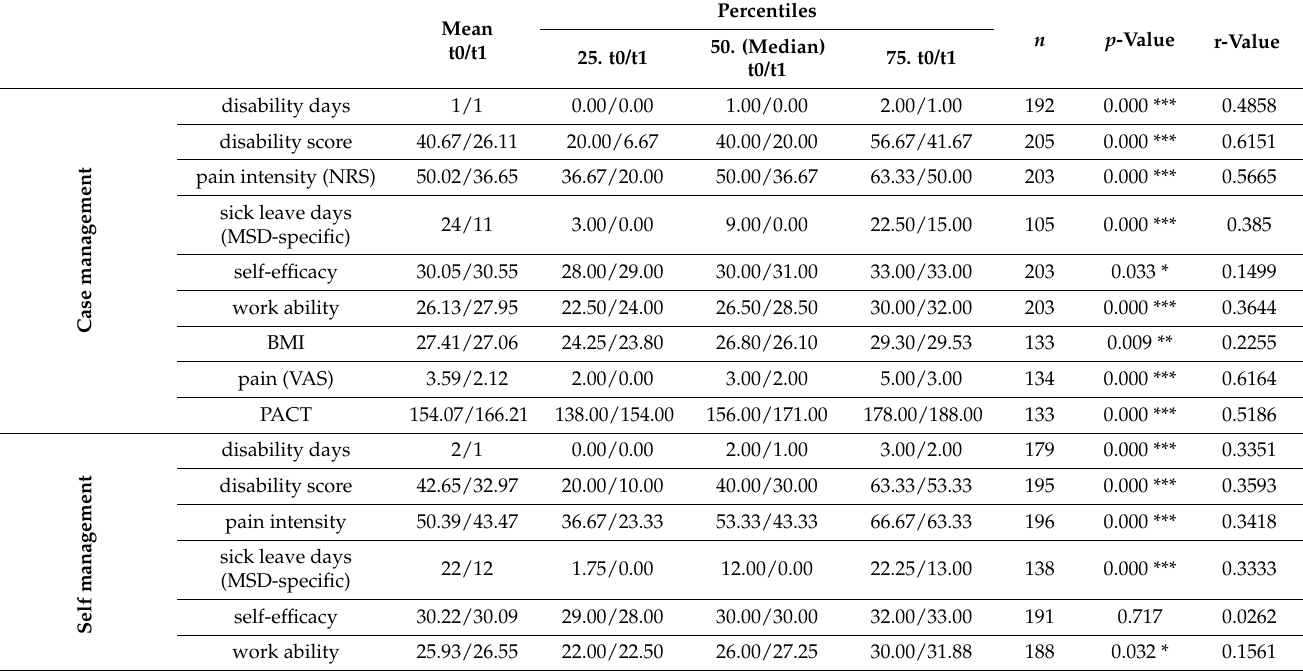
Table 4. Timepoint differences’ analyses in Module A: baseline (t0) vs. follow-up (t1), separately for coordinating case management (cCM) and supported self-management (sSM) (* = p < 0.05, ** = p < 0.01, *** = p < 0.001). (NRS = numeric rating scale, VAS = visual analogue